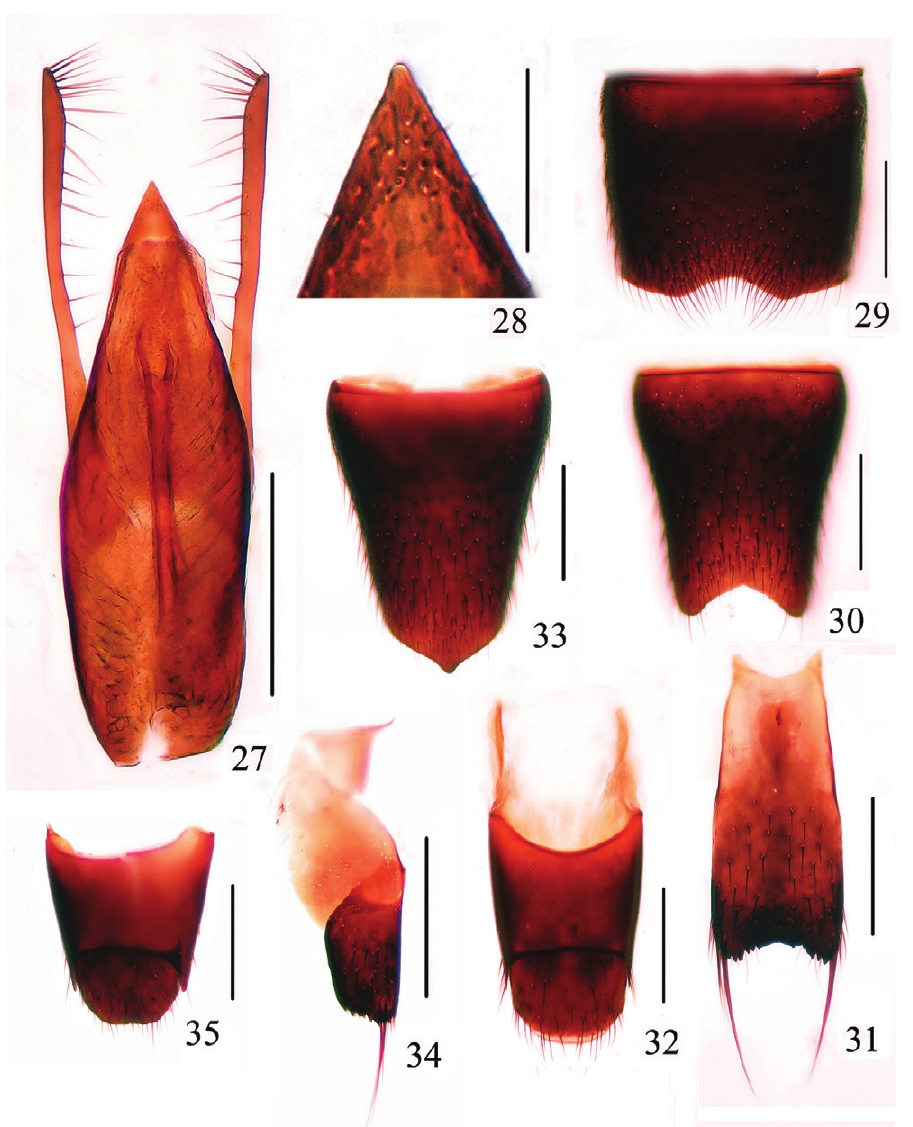
Figures 27–35. Dianous fengtingae . 27 aedeagus 28 apical portion of aedeagus 29 7th male